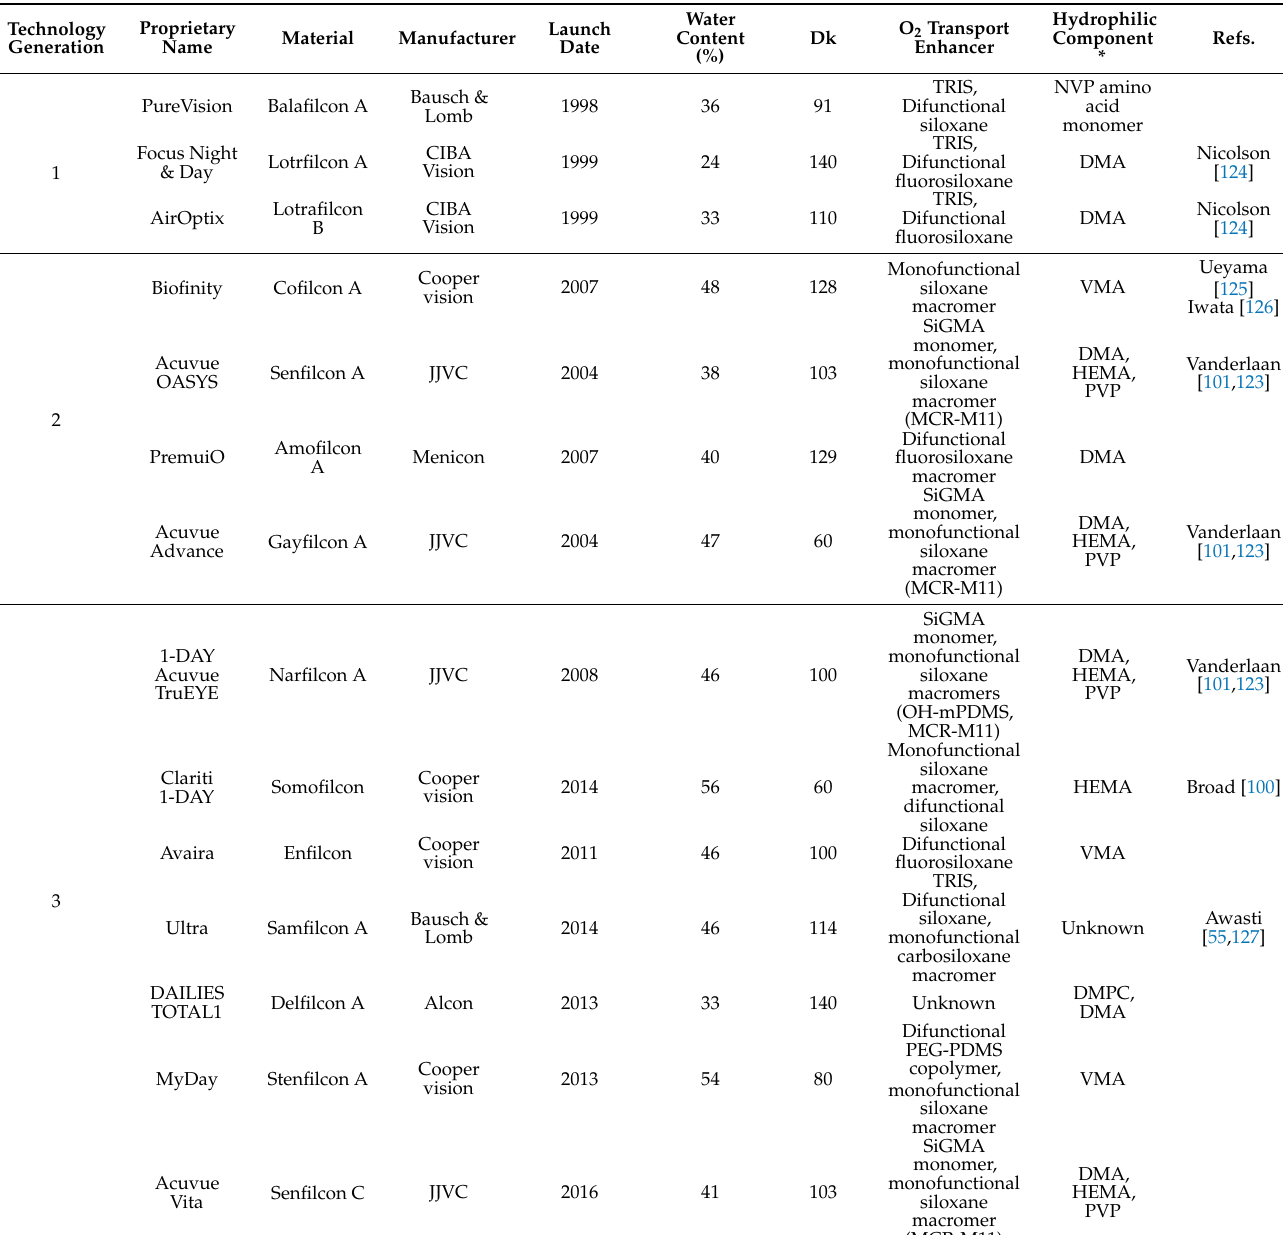
Table 7. Silicone Hydrogel Contact Lens Technology.